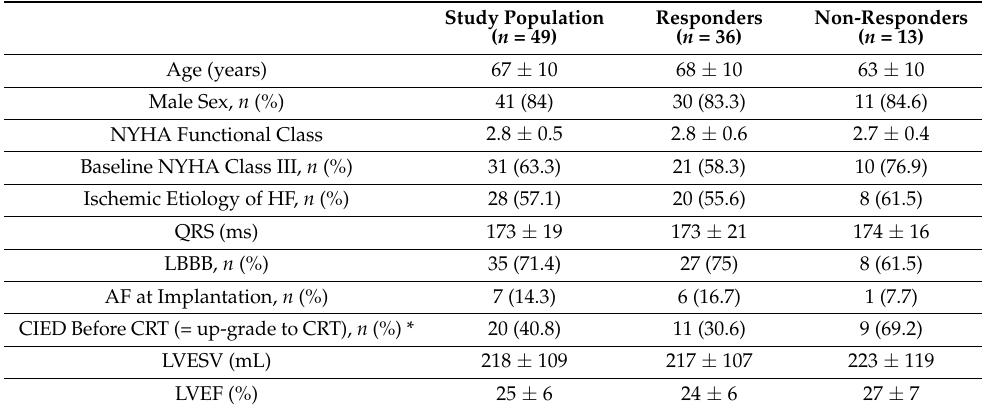
Table 1. Baseline characteristics of general population, responders and